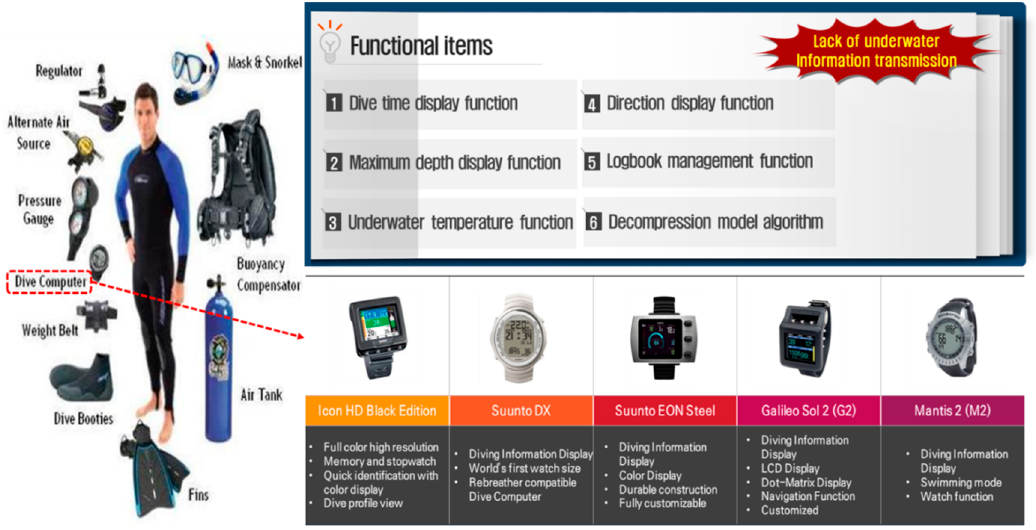
Figure 2. Functional items of conventional dive computers.